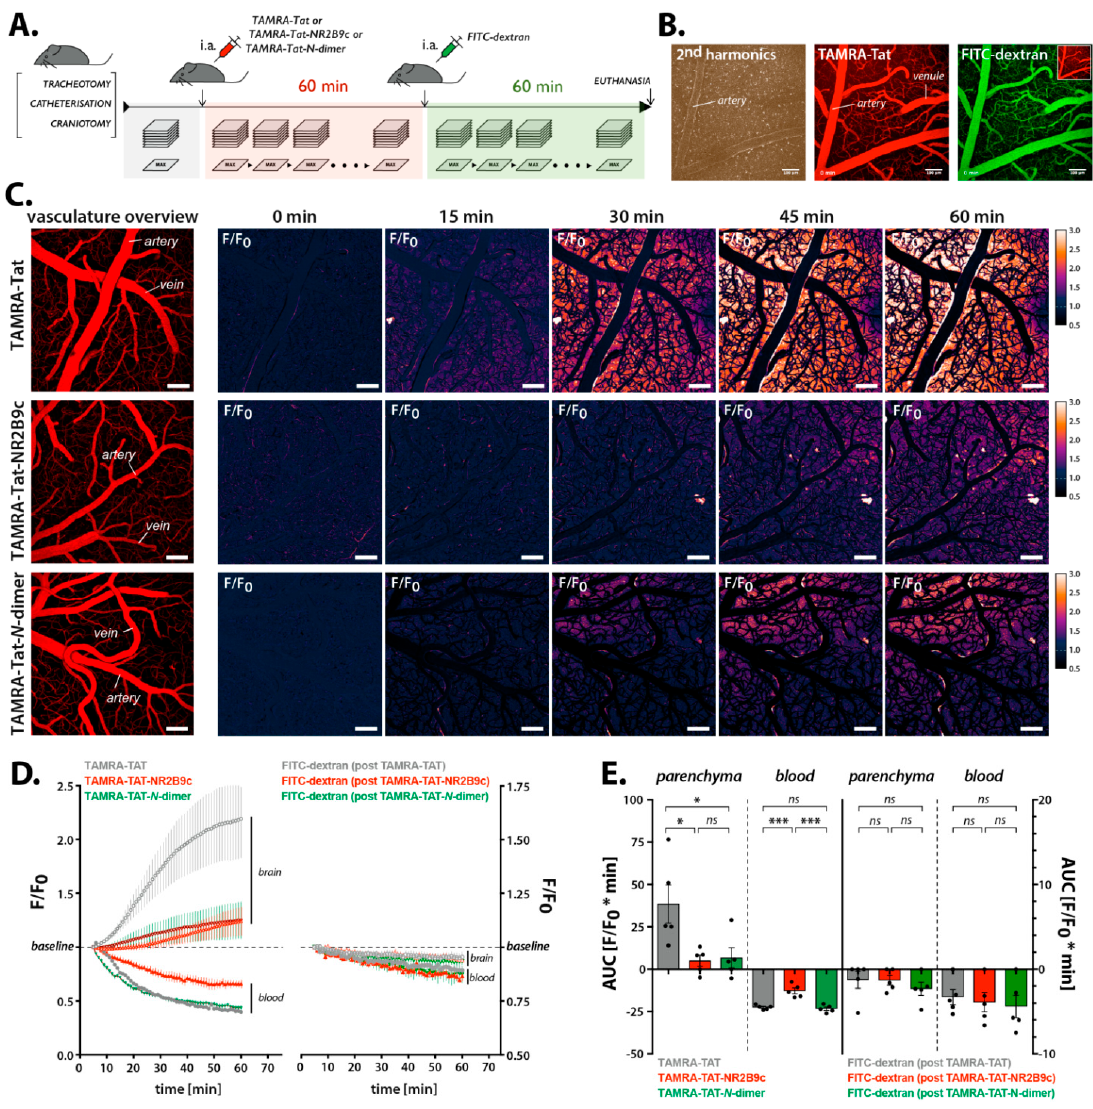
Figure 5. BBB permeation by the TAMRA-Tat-conjugated peptides was studied in C57BL/6 mice using two-photon fluorescence imaging. ( A ) Schematic timeline of the experiment, including surgical procedures and peptide administration, followed by administration of 2 MDa FITC-dextran as a control for mechanical damage of the BBB. ( B ) Second harmonics generation ( left ), baseline TAMRA-Tat fluorescence ( middle ), and baseline FITC-dextran fluorescence ( right ). ( C ) Time-lapse recordings of relative increases in fluorescence in the brain parenchyma following administration of TAMRA-Tat ( top ), TAMRA-Tat-NR2B9c ( middle ), or TAMRA-Tat- N -dimer (3 nmol peptide/g body weight). Scale bar: 100 µm. ( D ) Kinetic profiles presented as changes in fluorescence of the TAMRA-Tat-conjugated peptides ( left ) and FITC-dextran ( right ) in the brain parenchyma and vessels over time. ( E ) Total change in fluorescence of the TAMRA-Tat-conjugated peptides ( left ) and FITC-dextran ( right ) in the brain parenchyma and blood vessels presented as the area under the curve (AUC) obtained from the kinetic profiles. Data are presented as mean ± SEM (N = 5). * p < 0.05, *** p < 0.001 (two-tailed unpaired t -test).